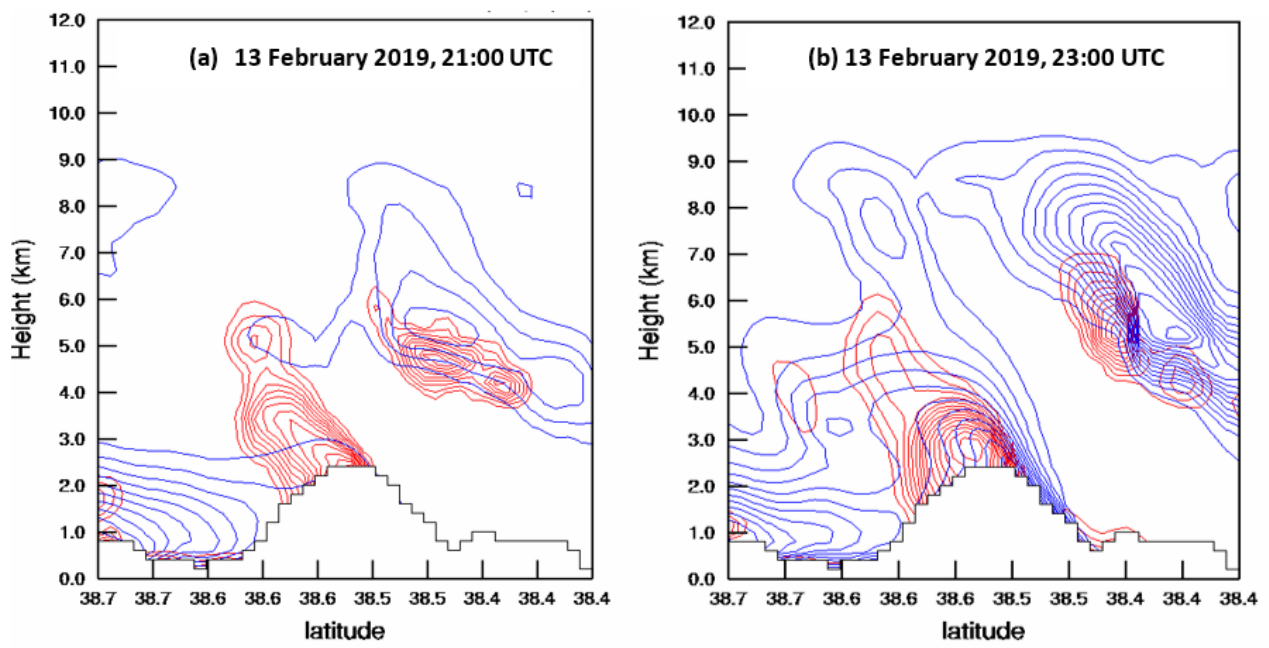
Figure 9. Modeled condensates mixing ratio: liquid (red contours every 0.04 g kg − 1 starting from 0.04 g kg − 1 ) and frozen (blue contours every 5.E-4 g kg − 1 starting at 5.E-4 g kg − 1 ): ( a ) 13 February 2019, 12:00 UTC; ( b ) 13 February 2019, 23:00 UTC.